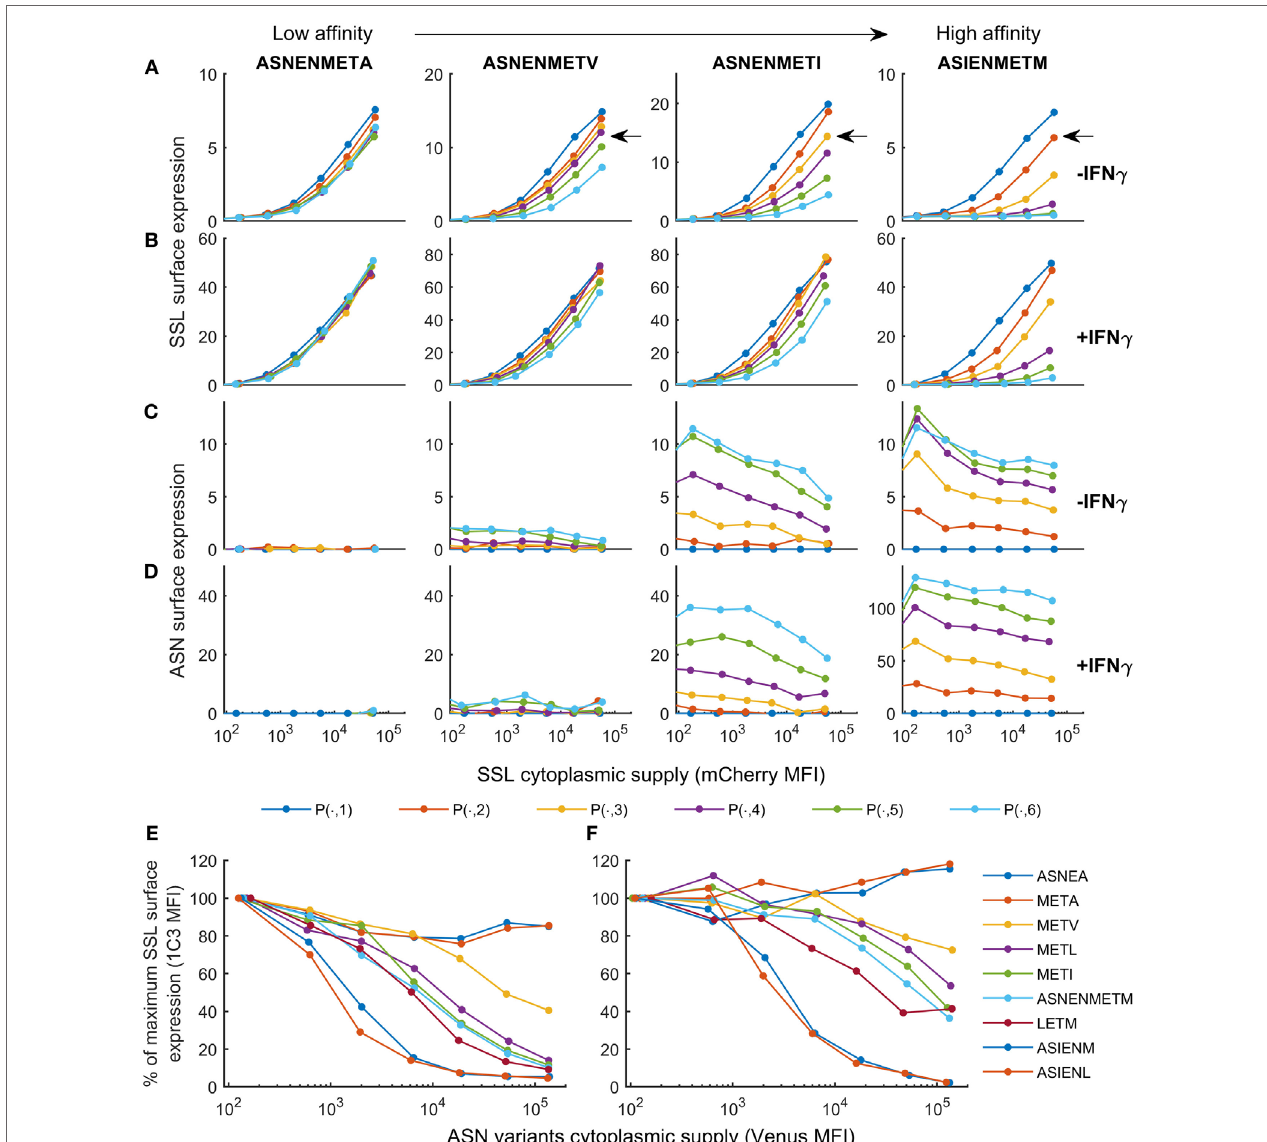
FigUre 3 | Cell surface abundance is differentially affected by competitor peptides with varying major histocompatibility complex stability. SSLENFRAYV-H2Db surface expression in the presence of ASN-variant peptides of different off-rates in untreated cells (a) and in cells treated with IFN γ (b) and corresponding ASN variants-H2Db surface expression in untreated cells (c) or in cells treated with IFN γ (D) . pMHC surface expression is plotted over the level of SSLENFRAYV peptide cytoplasmic supply, determined by the mCherry MFI, in the presence of increasing concentrations of the ASN variant peptides: the dark blue curve is obtained with no ASN variant expression [gates P ( n , 1)], the orange curve corresponds to gates P ( n , 2), etc. The arrows on the top graphs show a similar competition level achieved with a high concentration of a lower affinity peptide (ASNENMET V ) or lower concentrations of higher affinity peptides (ASNENMET i and AS i ENMETM). (e,F) Comparison of the level of competition in the presence of an increasing concentration of each ASN-variant peptide at constant SSL supply [gates P (7, )]. In order to normalize MFI between experiments the y -axis represents the percentage of maximum SSLENFRAYV-H2Db surface expression in P (7, 1). The x -axis represents the cytoplasmic expression levels of each ASN variant expressed as the Venus MFI. Untreated cells (e) and IFN γ -treated cells (F) were